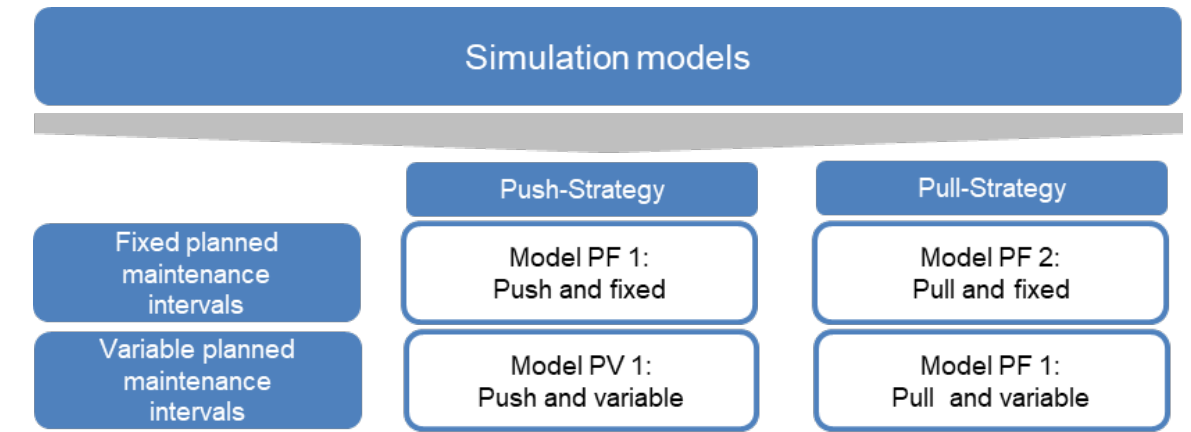
Figure 9. Simulation models developed for the research study (own elaboration).